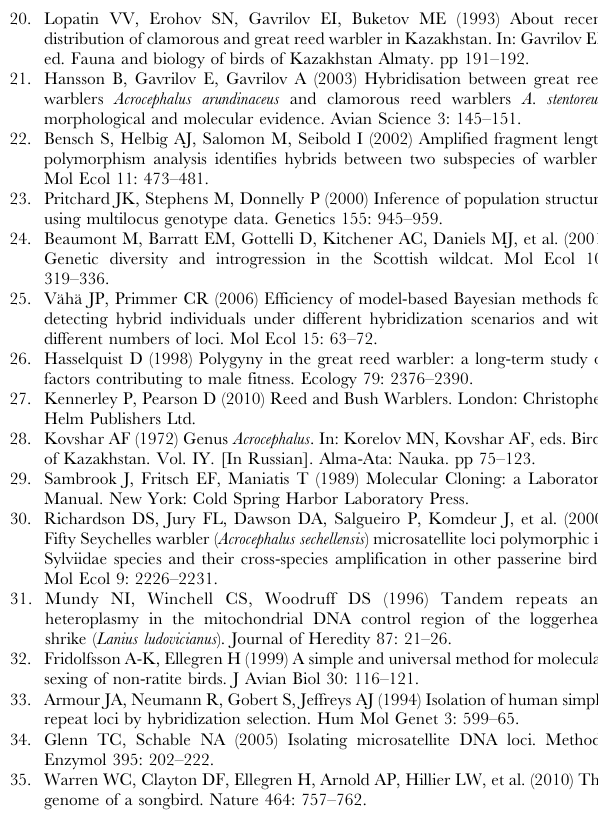
Table S1 Summary of BLAST analyses of 181 great reed warbler ( Acrocephalus arundinaceus ) microsatellite se- quences and four other avian microsatellite loci used in the present study against the zebra finch genome assembly (tgu3.2.4, build 1.1). BLAST hit statistics and chromosomal locations in the zebra finch genome are included. Table S2 Characteristics of 181 great reed warbler ( Acrocephalus arundinaceus ) microsatellite loci isolated